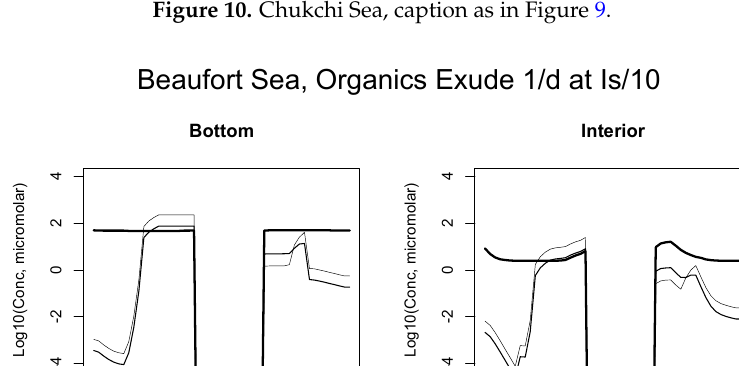
Geosciences 2017 , 7 , 52 Figure 10. Chukchi Sea, caption as in Figure 9. Figure 10. Chukchi Sea, caption as in Figure 9.